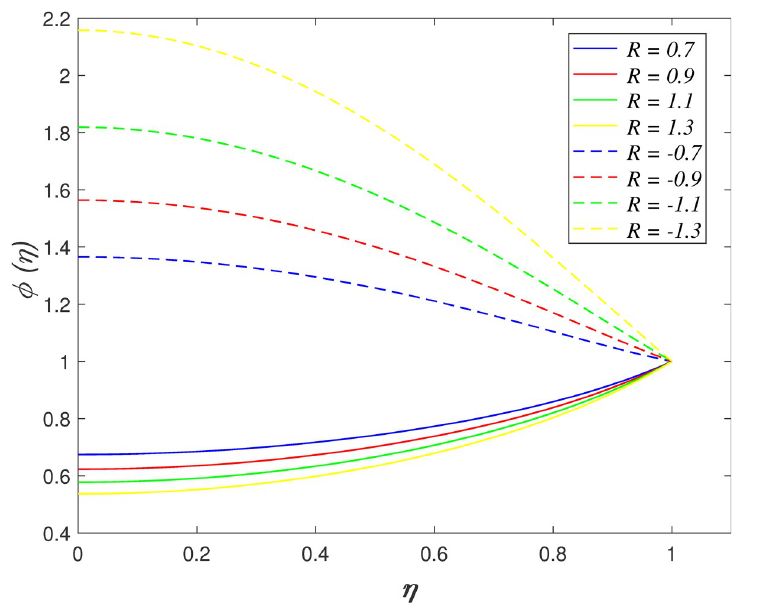
Fig 25. Impact of R on